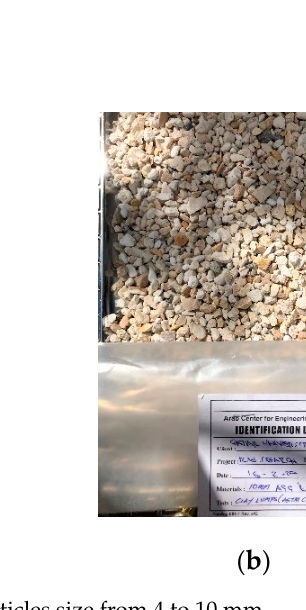
Figure 3. ( a ) Particles size from 10 to 20 mm, ( b ) Particles size from 4 to 10 mm.